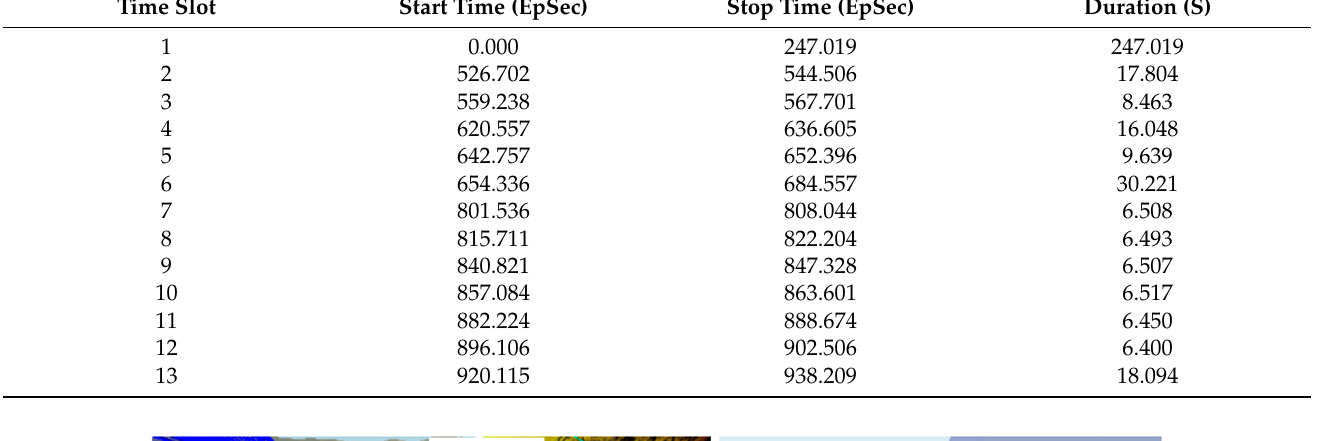
Figure 9. ( a ) 6-element RESM RX array and array local coordinate system, ( b ) an example of the first CBSA element radiation pattern.